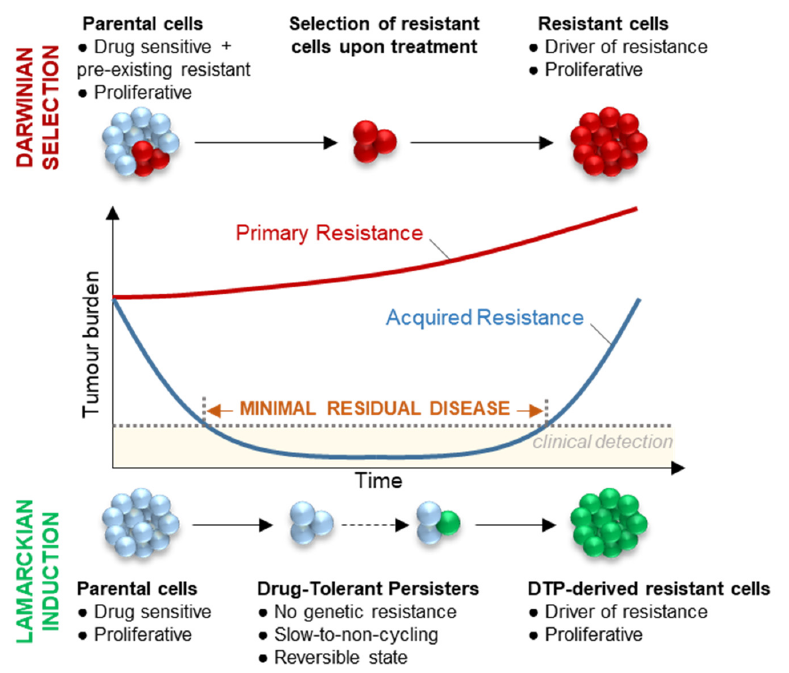
Figure 3. Schematic representation of the clinical response to targeted therapy in NSCLC patients. Primary resistance (red line) is characterised by a lack of initial response and a fast progression. Most patients display an initial response (blue line), with sometimes an apparently complete clearance of the tumour, although minimal residual disease persists and ultimately causes relapse in the vast majority of patients. Two hypotheses might explain the appearance of resistance for both primary and acquired resistance and might even co-exist within the same tumour. The Darwinian model suggests that, before the treatment, a population of sensitive cells (blue) co-exist with resistant cells (red) in treatment-naïve tumours, and pre-existing resistant cells are selected during treatment. The Lamarckian model suggests that a rare subpopulation of cells survives under treatment as the drug-tolerant persisters (DTPs). DTP cells exhibit non-genetic mechanisms of tolerance, slow-cycling capacities and a reversible phenotype, and could mimic the minimal residual disease phase observed in patients. DTP may eventually acquire drug-resistant mechanisms (green) and regain proliferative capacities. To study the minimal residual disease, several models are being used: most often cells treated with targeted therapies; xenograft models implanted in treated mice; and very rarely using biopsies from patients under treatment.